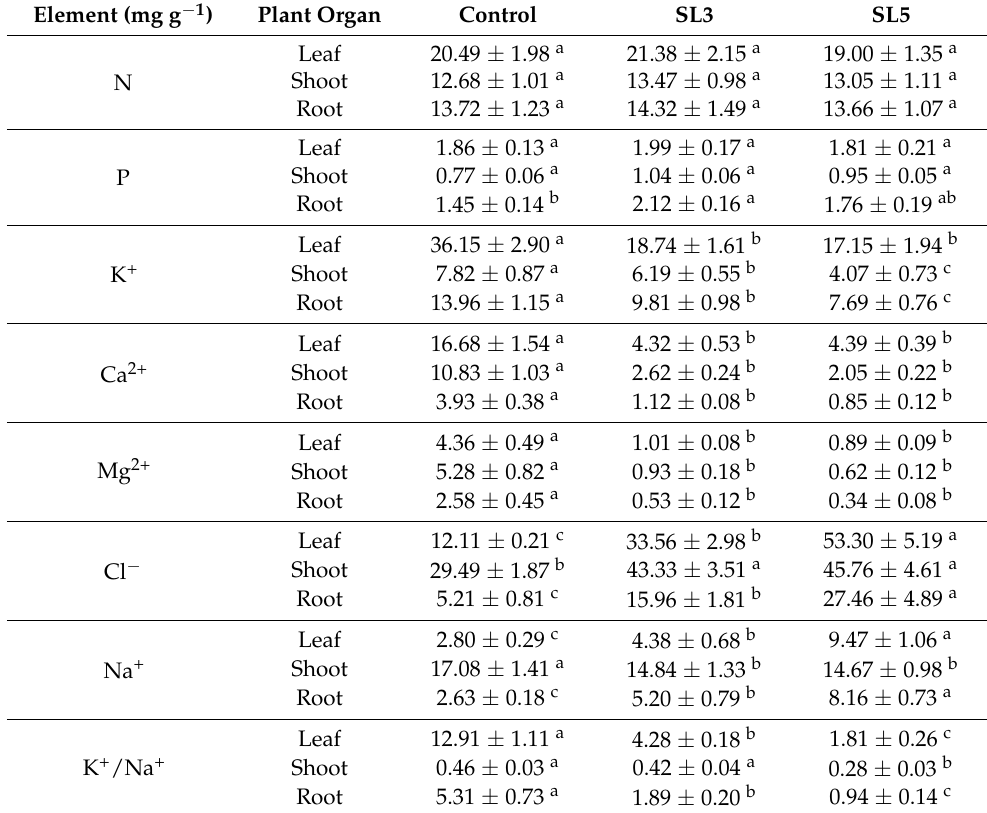
Table 4. Plant macronutrients (N, P, K + ) and mineral content (Ca 2+ , Mg 2+ , Na + , Cl − ) in leaves, shoots, and roots of Hebe at the end of the experiment. Control, SL3, and SL5 denote plants grown